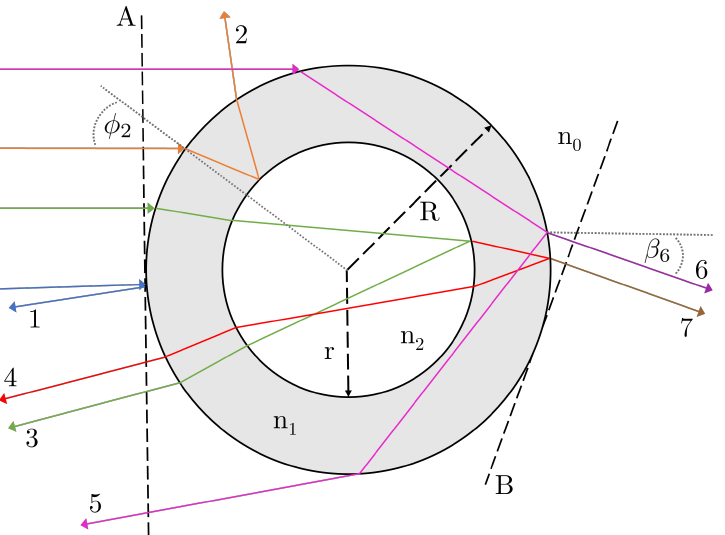
Figure 2. A diagram showing the different first-order rays that are possible in the capillary geometry of BSI. The incident angle of a given ray φ i is simply the angle to the surface normal. In the Xu/You et al.’s methodology, the angle of incidence is related to the viewing angle β i of each ray, where β i is defined to be the angle to the horizontal in this geometry. The example of β 6 is shown here. The diagram is adapted from that in You et al. [20]. The rays are demonstrative and not drawn with geometric